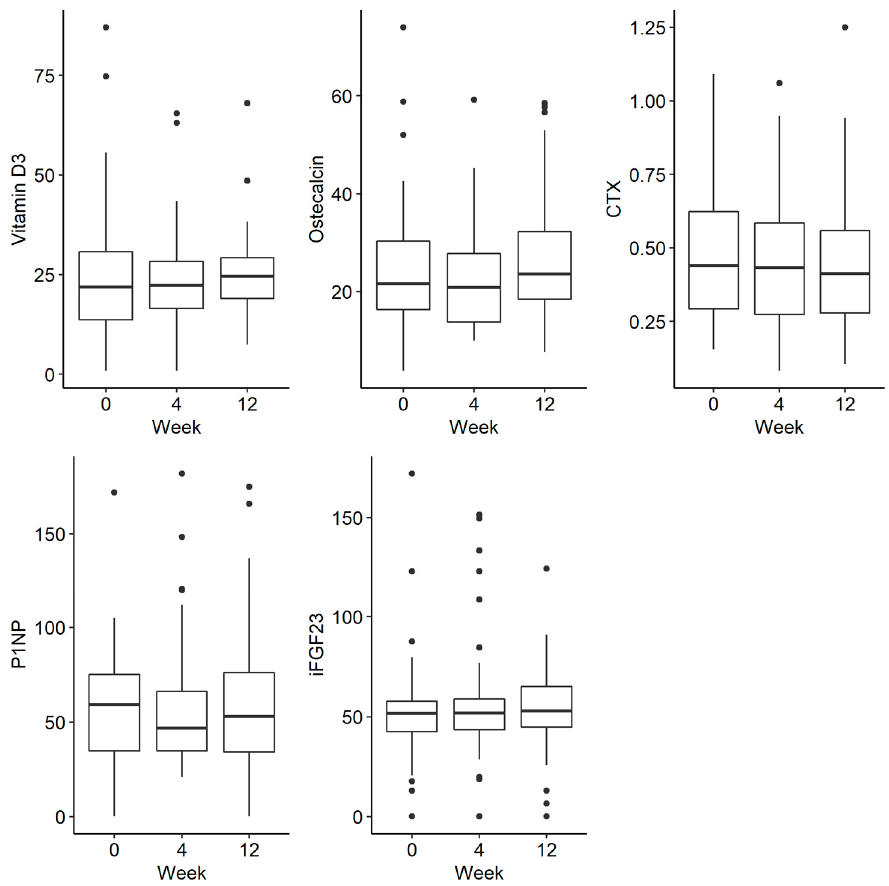
Figure 3. Changes in the concentration of vitamin D, osteocalcin, CTX (C-terminal telopeptide), P1NP (procollagen type 1N propeptide) and iFGF23 (intact fibroblast growth factor) before iron administration and 4 and 12 weeks after administration.